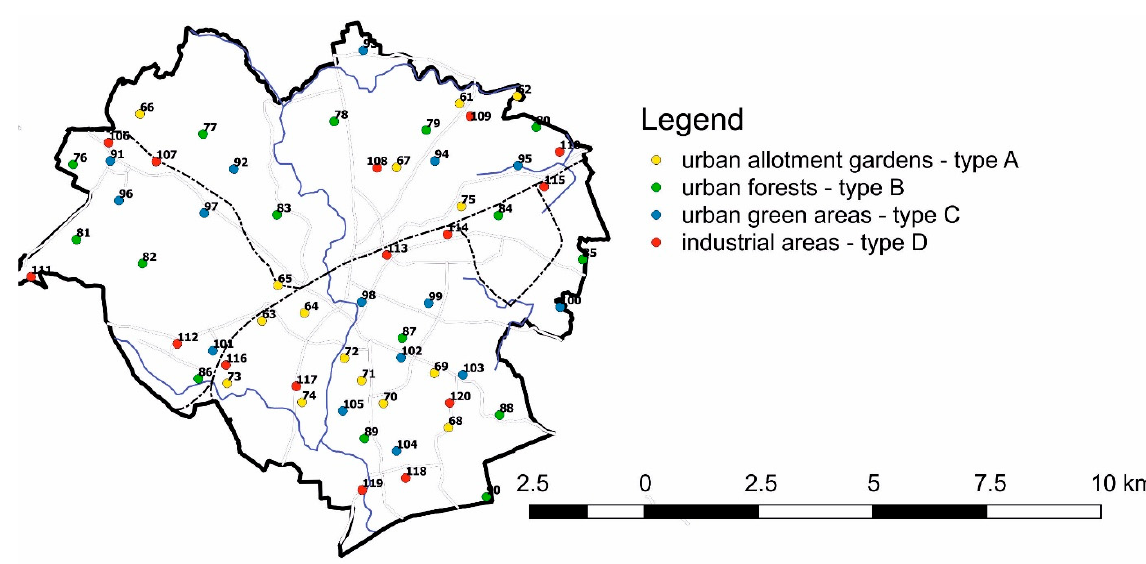
Figure 1. Location of soil and common dandelion sampling points in Kielce, including land-use types.